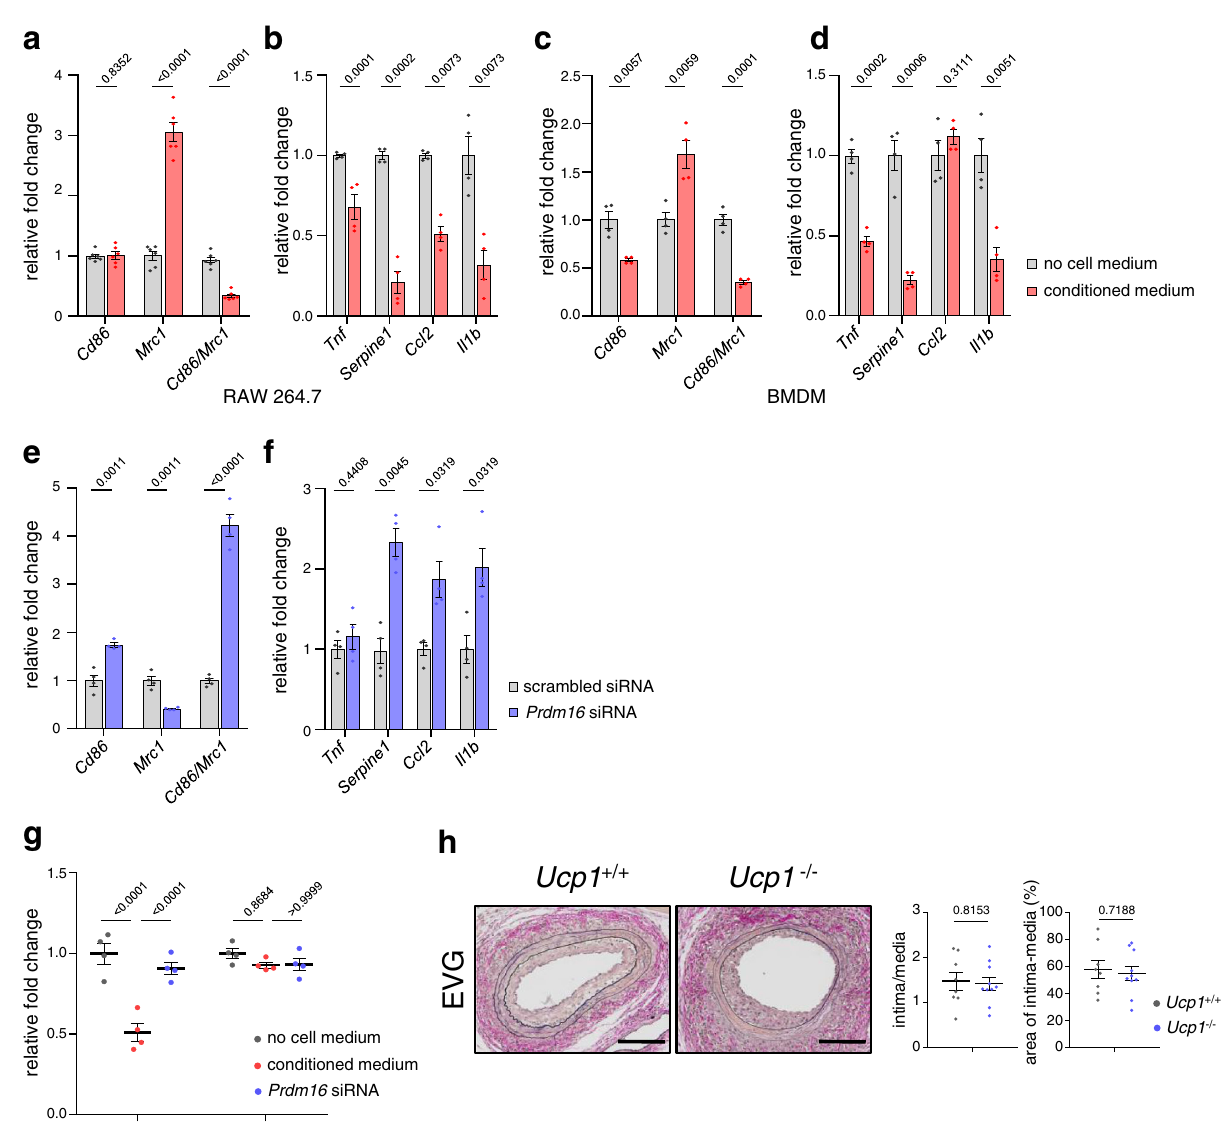
Fig. 3 | Beige-differentiated PVAT shifts macrophage phenotypes to alter- natively activated state. a – d Cultured preadipocytes isolated from the PVAT stromal vascular fraction were differentiated into beige adipocytes, and media conditionedbythe cellswereaddedto RAW264.7macrophage cells( a , b )orbone marrow-derived monocytes (BMDMs) ( c , d ). After 48h, mRNA was extracted from the RAW 264.7 cells or BMDMs and qRT-PCR was performed. The gene expression levels of macrophage phenotype markers [ Cd86 (classically activated), Mrc1 (CD206,alternativelyactivated)andratioof Cd86 to Mrc1 ,( a , c )]andin fl ammatory cytokines [ Tnf , Serpine1 , Ccl2 , and Il1b , ( b , d )] were analyzed. Control cells were treated with media cultured in the absence of adipocytes ( a n =6 biological repli- cates, representative data of three different culture lines are shown, two-tailed t tests with Holm-Sidak ’ s correction for multiple comparisons, b – d n =4 biological replicates,representativedataofthreedifferentculturelinesareshown,two-tailed t tests with Holm-Sidak ’ s correction for multiple comparisons). e – f PVAT- preadipocytes were introduced by siRNA of Prdm16 or scrambled and stimulated with beige differentiation factors. Culture media conditioned by these cells were addedtoRAW264.7cellsandmRNAwasextracted48haftertreatment.Theresults